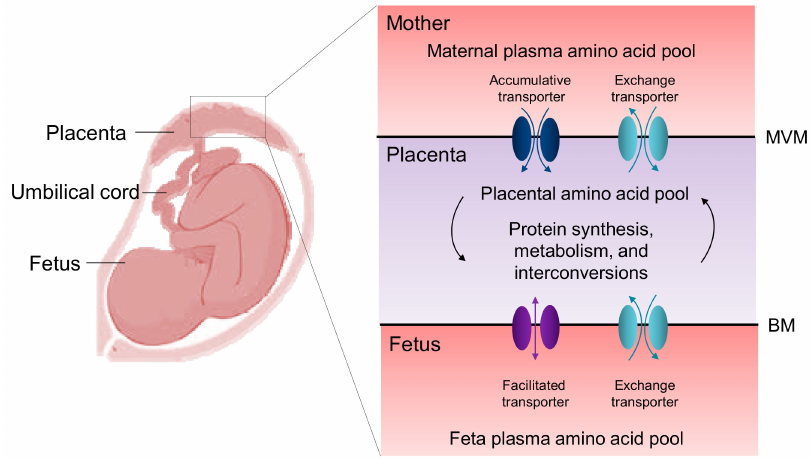
Figure 2. Schematic illustration of the placental amino acid transporters within the microvillous membrane (MVM) and basal membrane (BM) of the placental syncytiotrophoblast. Accumulative transporters located in the MVM mediate the uptake from the maternal circulation until their accumulative potential is reached. Exchange transporters mediate the net influx of abundant external amino acids in exchange for the e ffl ux of relatively more abundant intracellular amino acids. Facilitated transporters on the BM mediate the e ffl ux of amino acids down the concentration gradient into the fetal circulation. The placental amino acid pool can be regulated by protein synthesis, metabolism, and